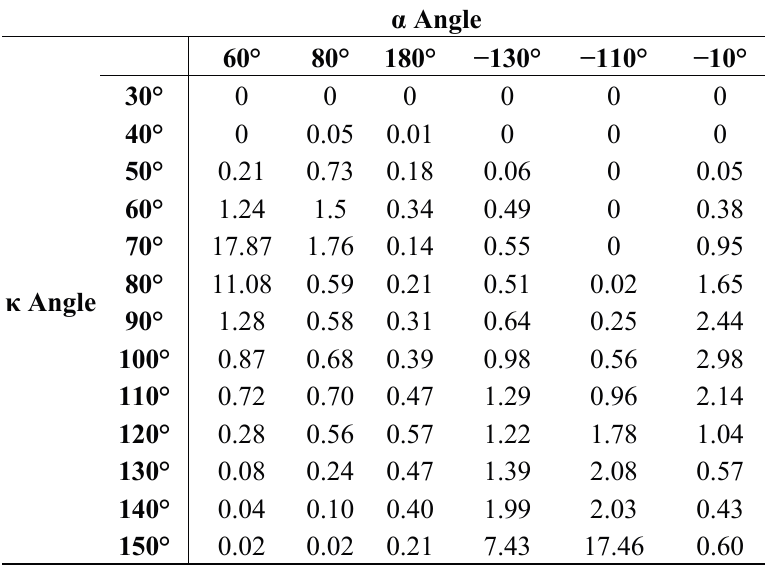
Table 2. ( κ , α ) pair backbone angle preferences